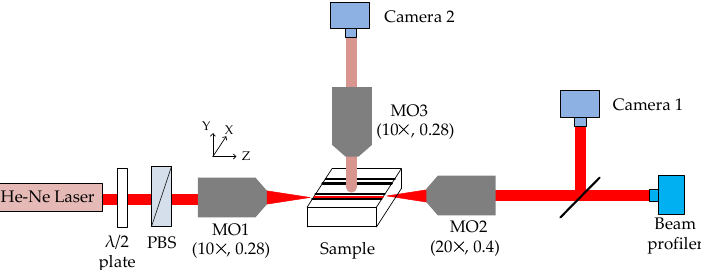
Figure 6. Schematic of the waveguide characterization set up.